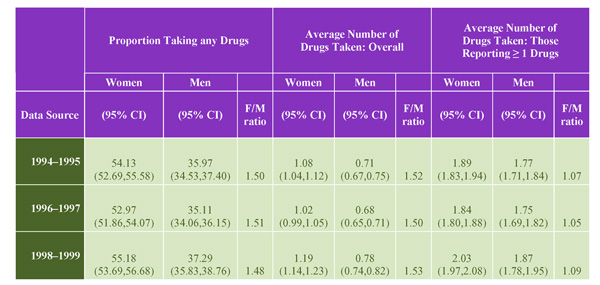
Proportion of Canadians, 20 Years and Older, Using Any Medication and Average Number of Different Drugs Used. Source: Statistics Canada, NPHS, various years.These data are based on "preceeding 2 days use" and are age standardized to the 1991 Canadian population